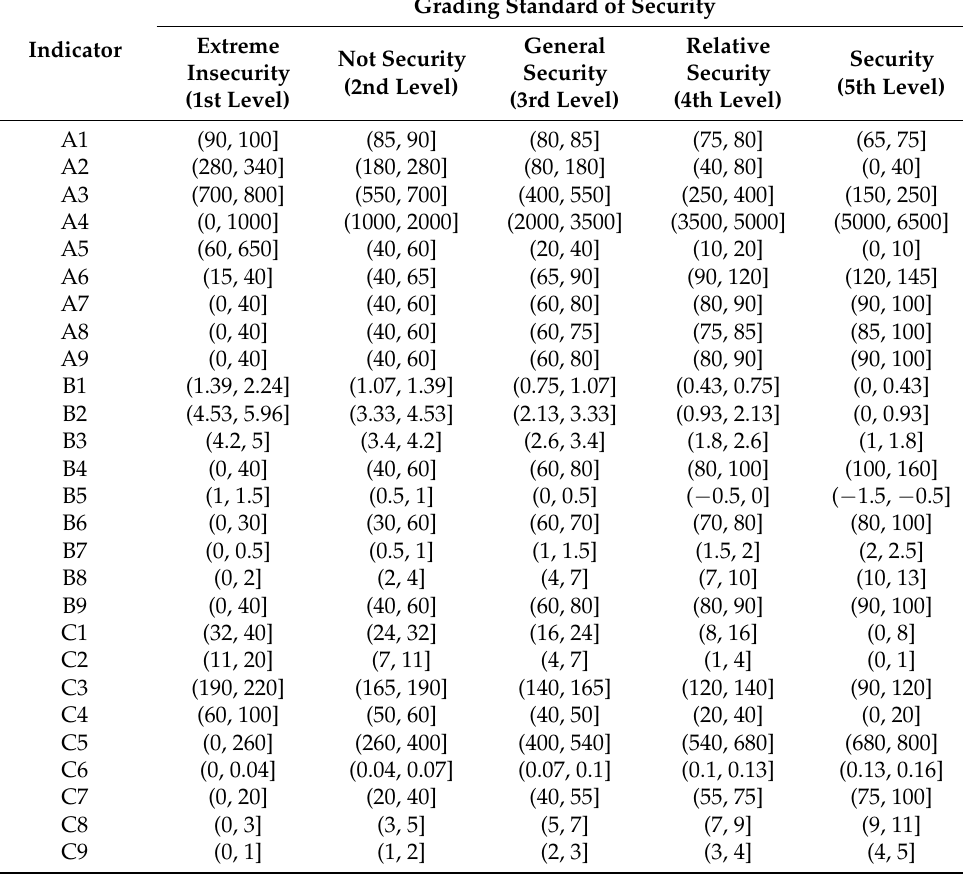
Table 2. Evaluation indicator standards for water-energy-food system security.